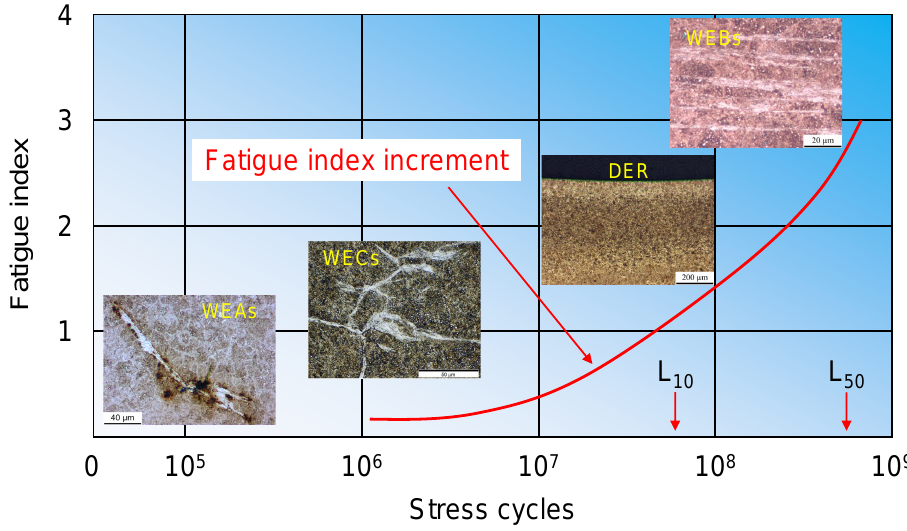
Figure 1. Appearance sequence of various microstructural alterations during the RCF of a 100Cr6 bearing steel. The increments of the fatigue index were based on the RCF test conducted with contact pressure of 3.4 GPa at room temperature. The image is drawn by referring to [7]. The image of WEAs was adapted from ref. [8], and the image of WECs was adapted from ref. [9]. Copyright 2019 Springer Nature; the image of DERs was an unpublished image, and the image of WEBs was adapted from ref.